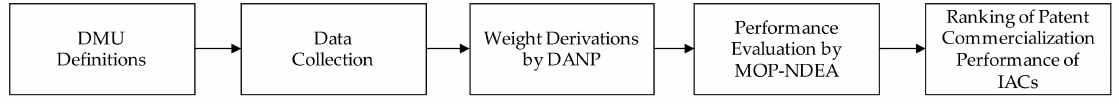
Figure 3. Analytic